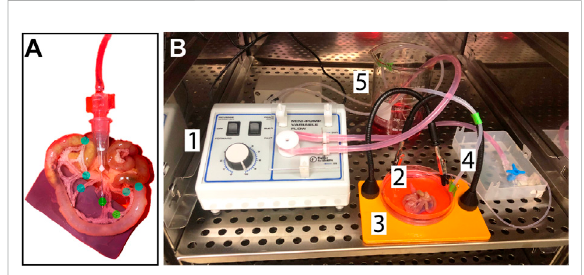
FIGURE 1 Experimental Design and Setup Schematics. (A) Close-up of thecatheterinsertionpointandsuturepoints:Thegreendotslabel the needle insertion point, which is secured with tissue adhesive, and the occlusion suture. The blue dots label sutures made on neighboring, non-catheterized arteries and on the intestine on either end of the area of interest. These sutures serve to emulate the resistance that would be present in-vivo from blood fl ow. (B) Set up of the controlled- fl ow tissue culture environment: 1. The peristaltic pump provides controlled fl ow of the perfusate (MEM with 1% penicillin-streptomycin and 10% fetal bovine serum) at a fl ow-rateof1 ml/min via anarterialcatheter,2.3.Thetissueiskept in the same media solution acting as the perfusate to create a closed circuit where the media volume in the dish is controlled by a secondary pump, 4, and deposited back into the reservoir to be cycled again, 5. All components are maintained at 37 ° C and 5% CO 2